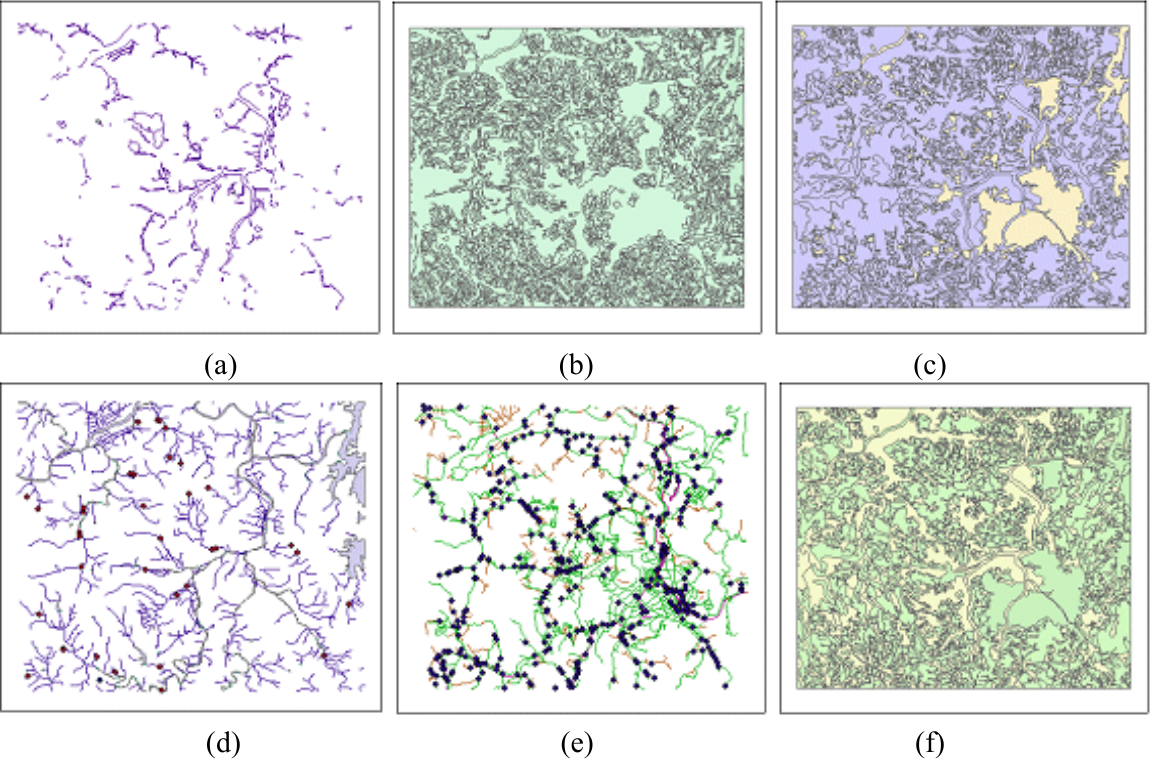
Figure 1. VITD’s Six Layers. (a) Obstacle (OBS). (b) Topography (SLP). (c) Soil